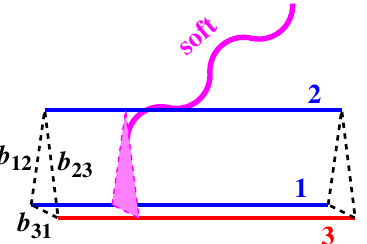
Figure 13 . Soft radiation from three hard lines somewhere in the middle of a hard g → gg splitting process. This is a magnified view of one of the soft vertices in figure 2, and here the magenta triangle is just a way to represent that the soft gluon can couple to any one of the three hard lines.